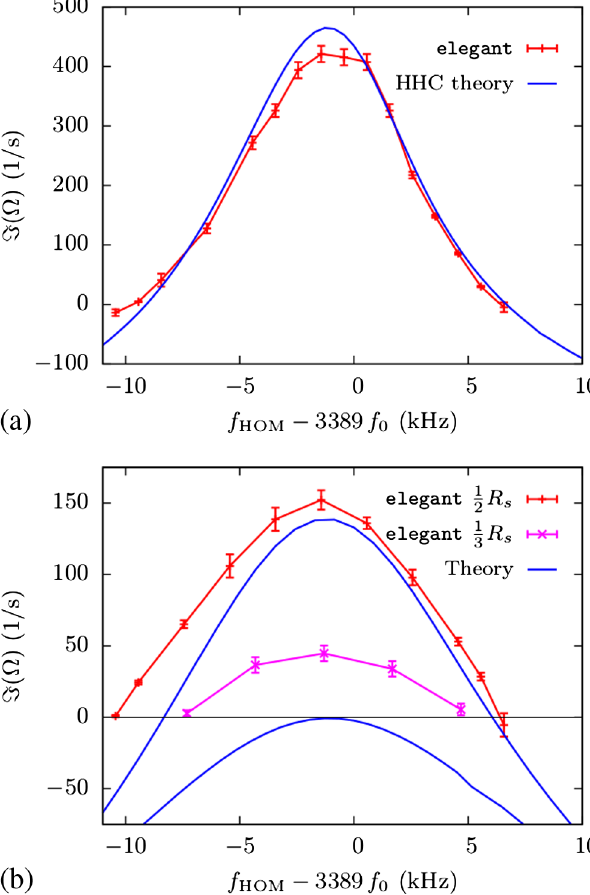
FIG. 3. Comparison of theory (blue) to ELEGANT simulations (red) of the predicted and observed multibunch growth rate including synchrotron radiation. Panel (a) plots the results for the 921 MHz HOM using parameters from Tables I and II, i.e., is identical to Fig. 2(b) but for the inclusion of synchrotron emission, which we model in the theory by simply subtracting off the synchrotron damping rate of 49 1 = s. The agreement is quite good. Panel (b) shows that the agreement becomes less impressive as one approaches the instability threshold. The red line shows that halving the shunt impedance (and, hence λ ) agrees reasonably well; on the other hand, while subtracting the damping time from the theory predicts stability when R s is cut by one-third, the simulations show an instability near